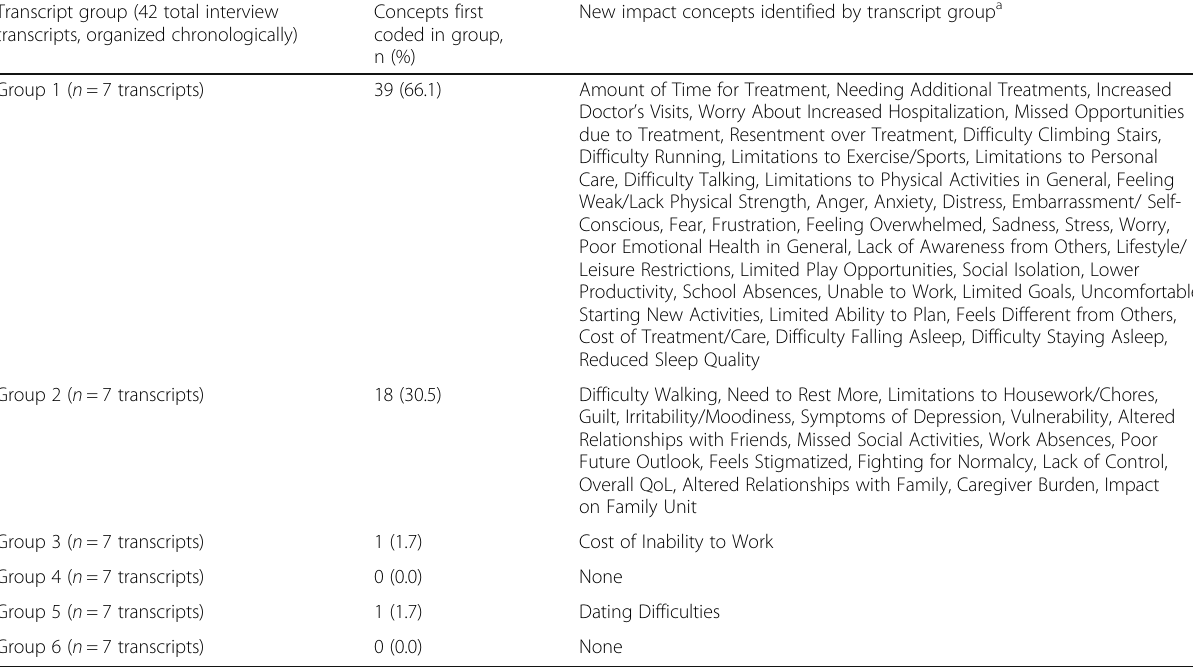
Table 2 Concept saturation: identification of novel CF impact concepts by transcript group Transcript group (42 total interview transcripts, organized chronologically)